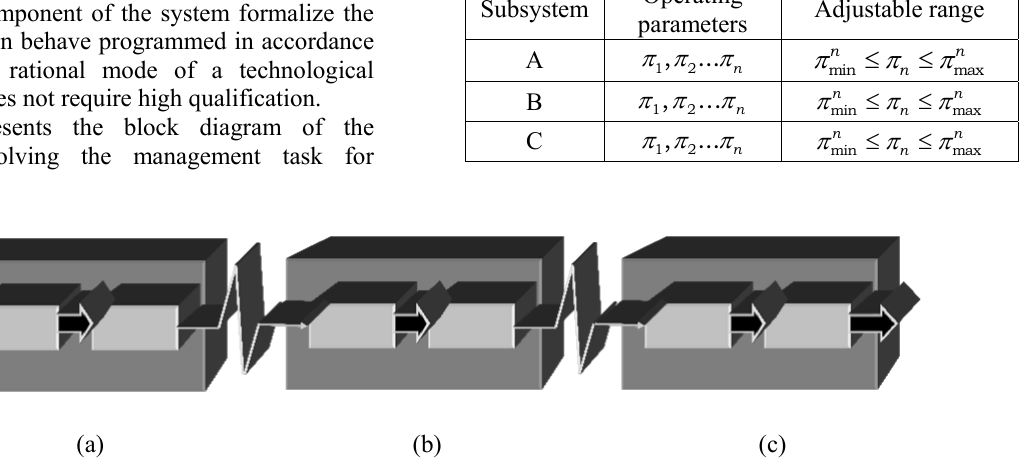
Fig. 1. Schematic structure of a technological flow with a semi-rigid